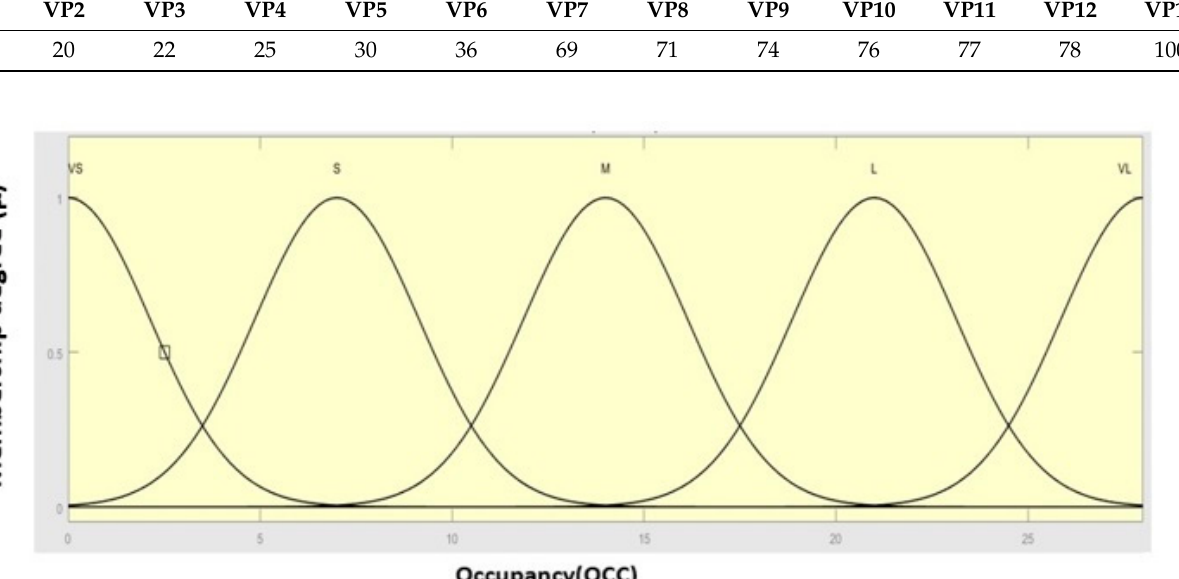
Figure 7. Membership functions of the occupancy ( OCC ). VS: very small, S: small, M: medium, L: large, VL: very large.